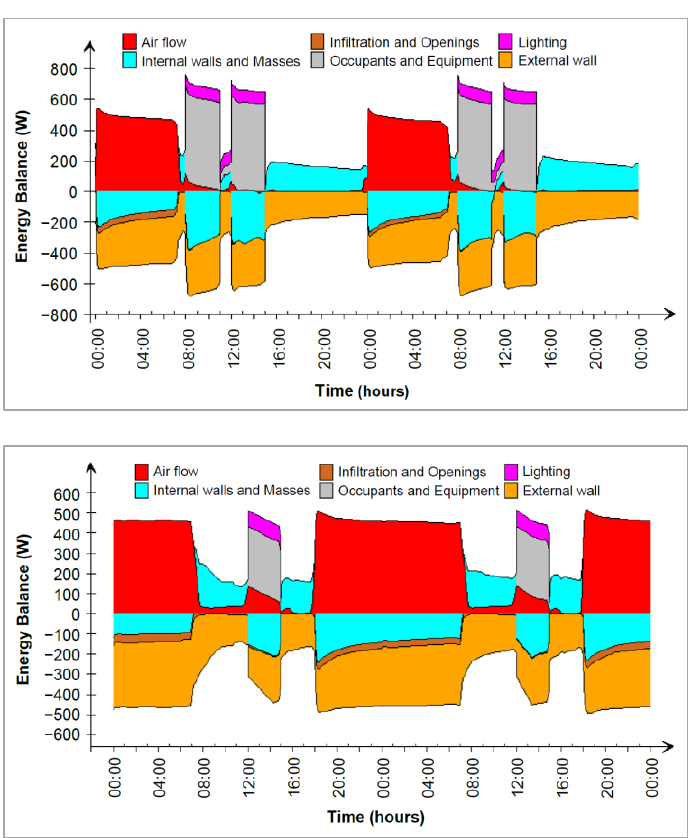
Figure 18. Simulated energy balance for Scenario I ( top ) and Scenario II ( bottom ) of the lab test.